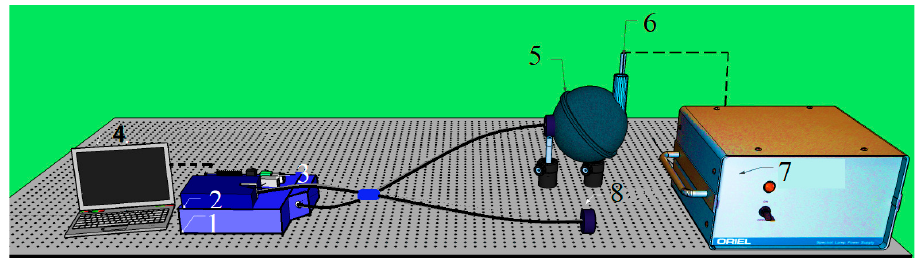
Figure 4. Report on Piccolo system calibration for QEPro 01652 as an example provided by Piccolo system suppliers.